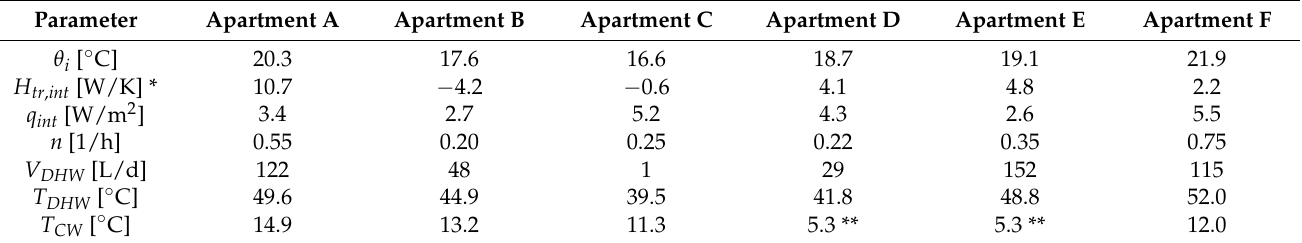
Table 3. Actual use internal parameter values obtained during tests [20].